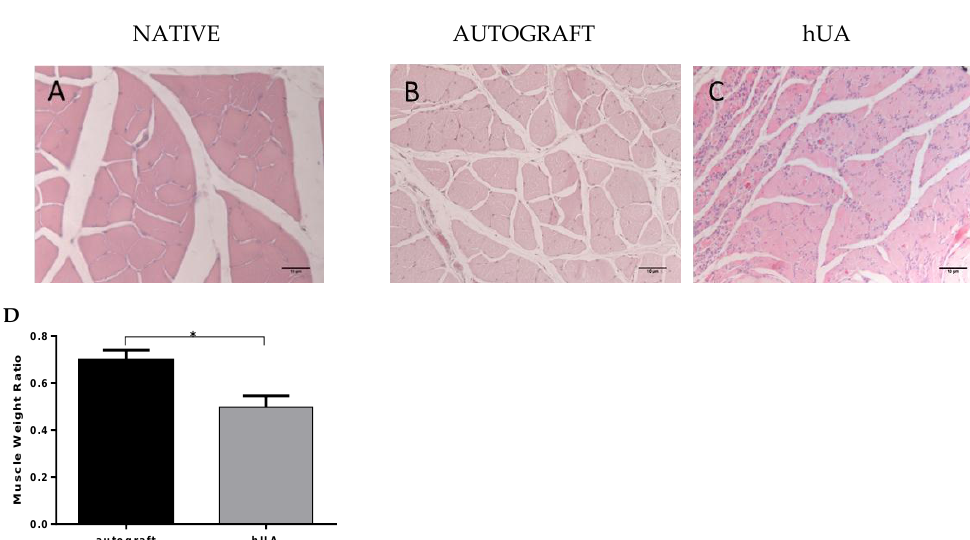
Figure 7. Gastrocnemius muscle histology and weight ratio. ( A – C ) gastrocnemius muscle transverse section stained with H&E from normal, autograft group and hUA group, respectively. Original magnification 40 × ; ( D ) muscle weight ratio was evaluated and compared by statistically analysis * p < 0.05.